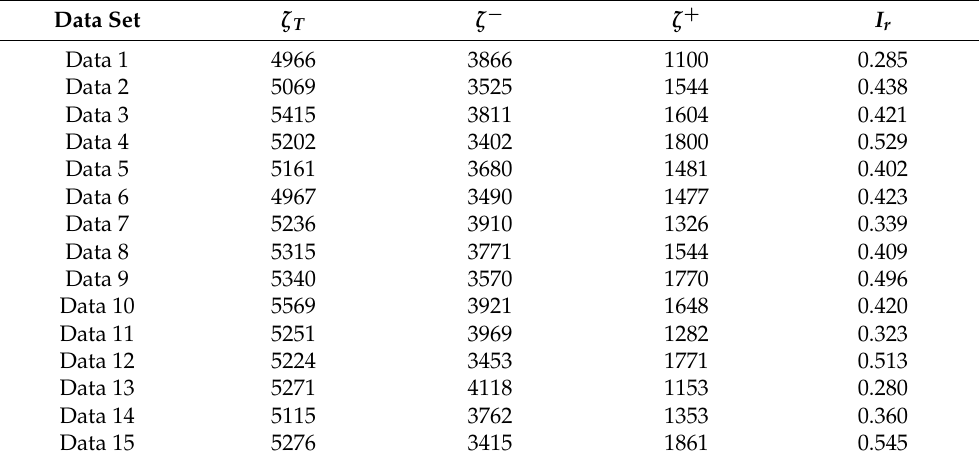
Table 1. The characteristics of power system data sets. Imbalance ratio ( I r ) less than 0.4 indicates highly imbalanced data